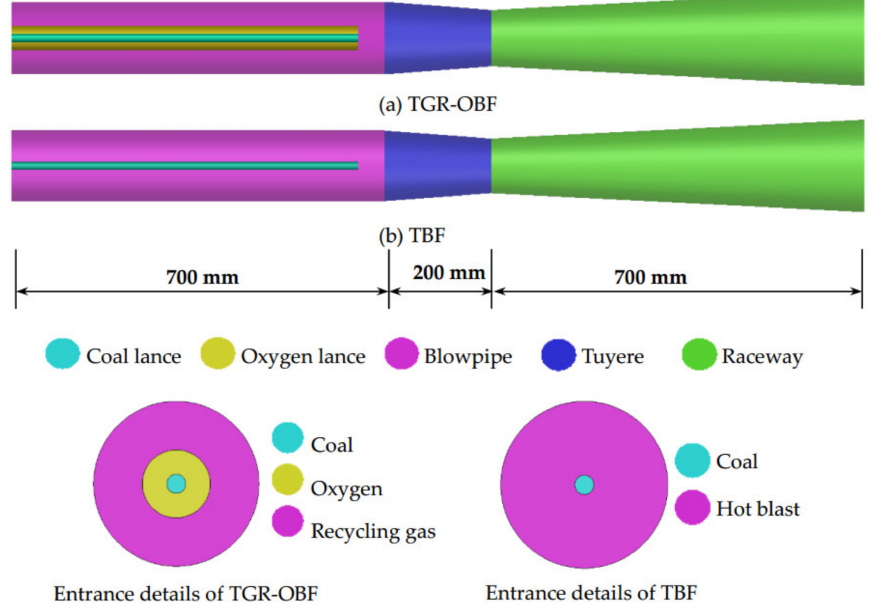
Figure 2. Geometric details of the